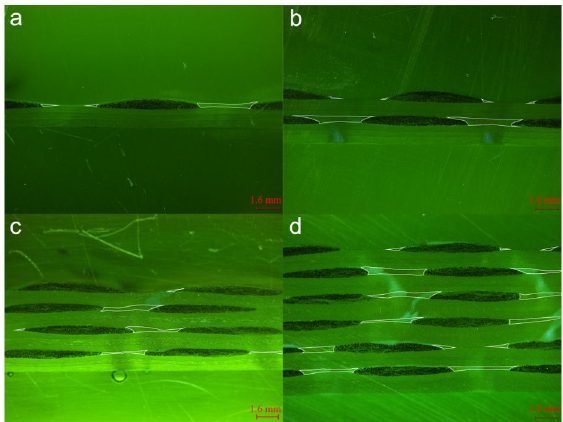
Figure 4. Weft cross-section views of ( a ) 1-layer; ( b ) 2-layer; ( c ) 4-layer; ( d ) 6-layer quadriaxial NCF reinforced laminates.